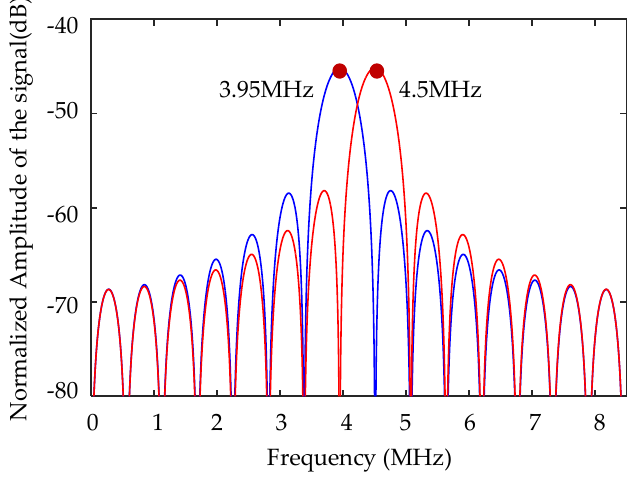
Figure 12. The signal of BTM (Upp = 1 V).